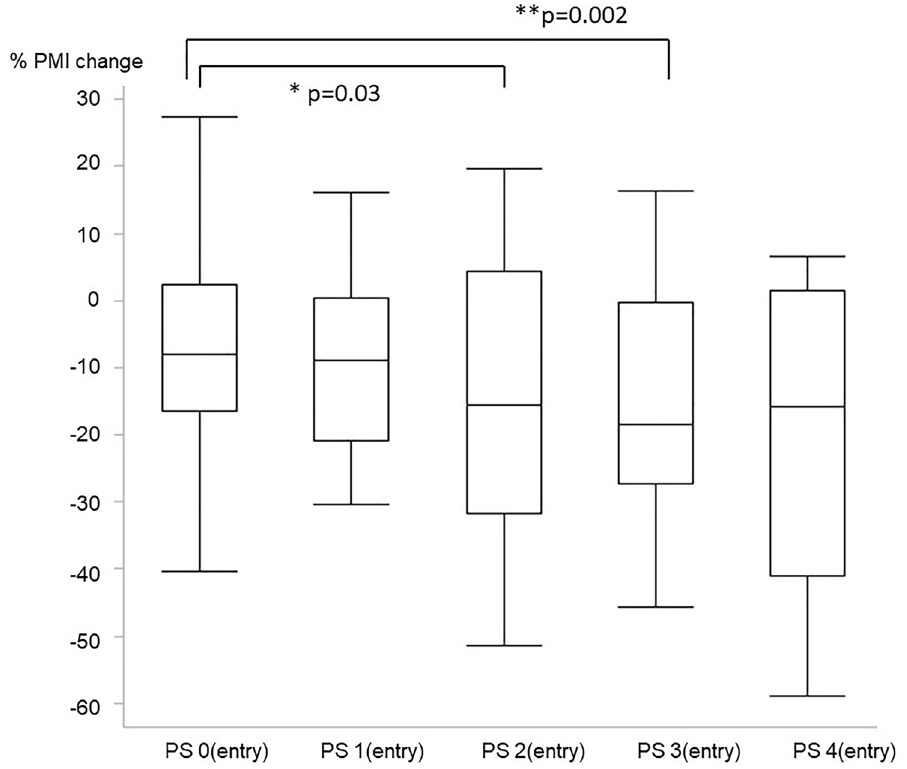
Figure 2. Association between percent change in the psoas muscle (%PMI) and the Eastern Cooperative Oncology Group Performance Status (ECOG-PS) scale at entry. PS: Eastern Cooperative Oncology Group Performance Status. Patients with ECOG-PS 2 and 3 at entry had greatly decreased muscle mass compared to those with ECOG-PS 0. Statistical analyses were performed using the JMP Pro 15.0.0 (3903308).